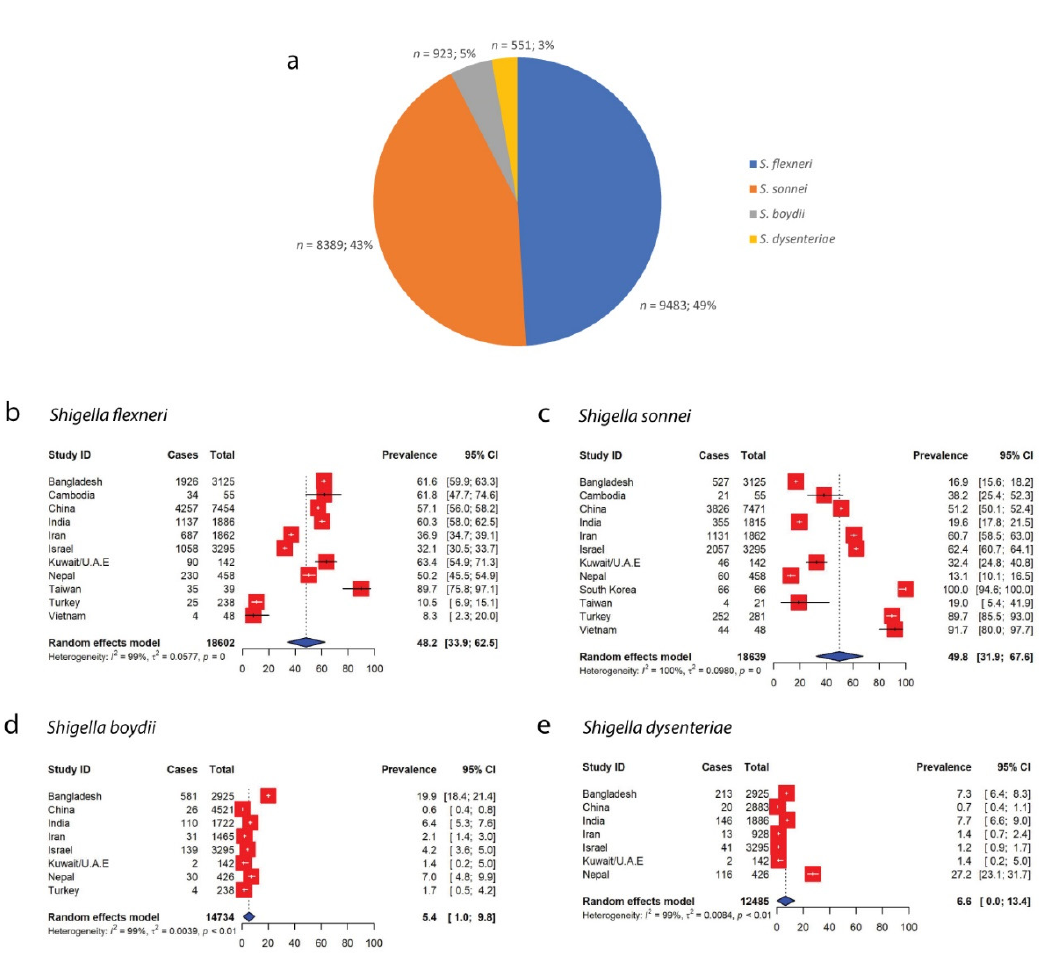
Figure 4. Distribution of different species of Shigella across Asian countries. ( a ) Proportions of different species of Shigella . S. flexneri constituted the highest proportion of Shigella isolates in Asia (49%, n = 9483), followed by S. sonnei (43%), S. boydii (5%) and S. dysenteriae (3%). ( b ) Forest plot representing the pooled Asian prevalence of S. flexneri . ( c ) Forest plot representing the pooled Asian prevalence of S. sonnei . ( d ) Forest plot representing the pooled Asian prevalence of S. boydii . ( e ) Forest plot representing the pooled Asian prevalence of S. dysenteriae . Table 3. Pooled prevalence estimates of antimicrobial drug-resistant Shigella spp. tested against 49 antibiotics in